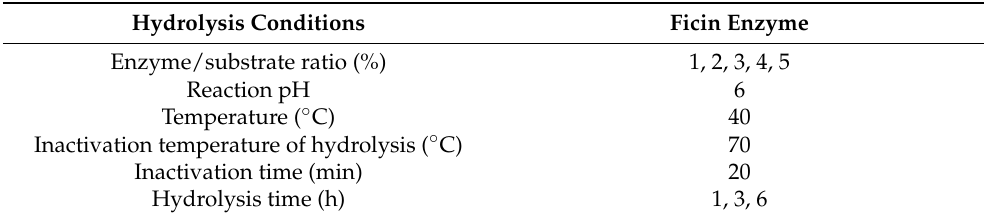
Table 1. Enzymatic hydrolysis conditions for obtaining protein hydrolysates from bighead carp (Hypophthalmichthys nobilis) using ficin